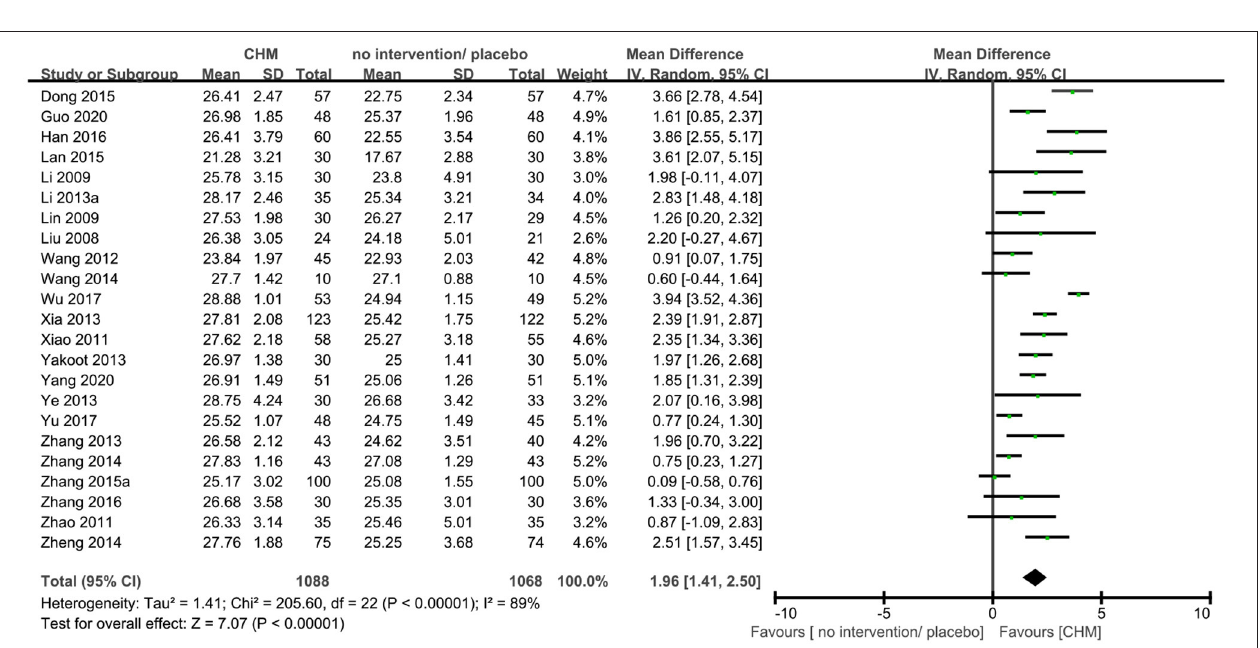
FIGURE 5 | Forest plot of comparison: CHM vs. no intervention/placebo, outcome: MMSE.